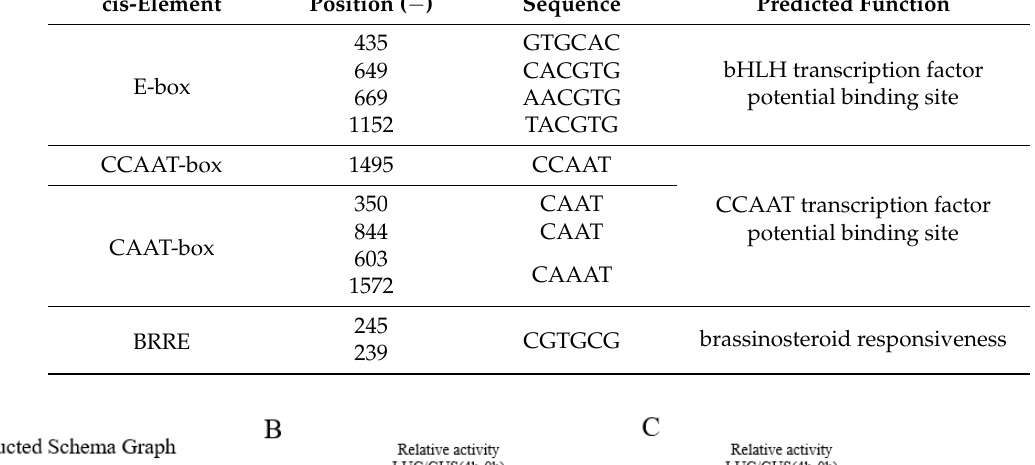
Table 1. Prediction of cis-acting elements of ZmC4 NADP-ME promoter.